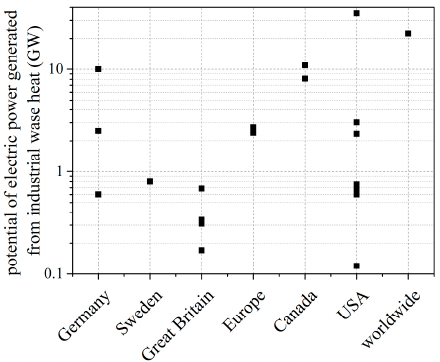
Figure 1. Potential of electric power generated from industrial waste heat in different regions (operating hours: 8760 h/a).